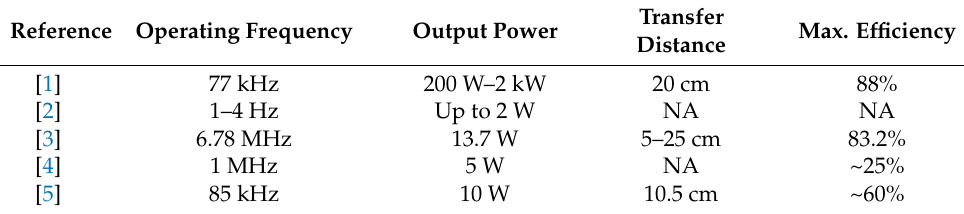
Table 1. Comparison of the published papers in terms of system parameters and